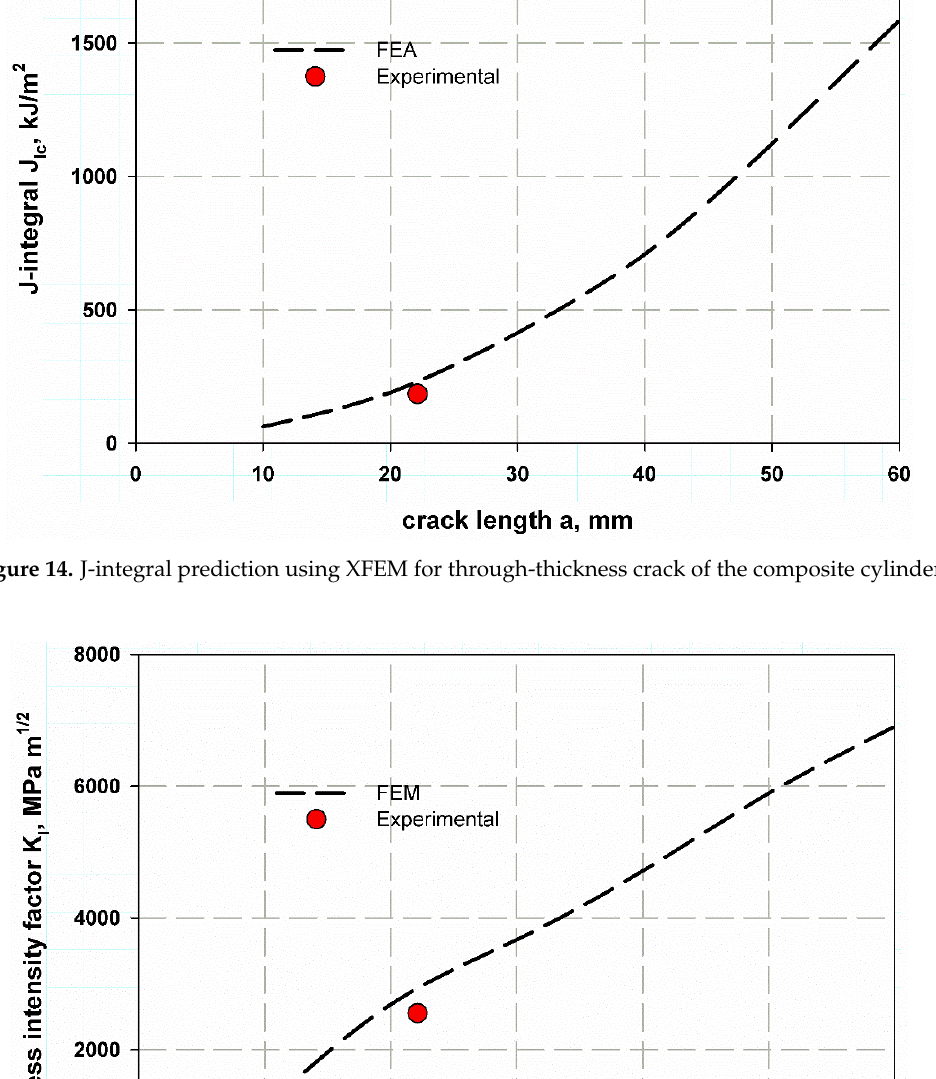
Figure 13. Nominal hoop stress versus the normalized crack length.